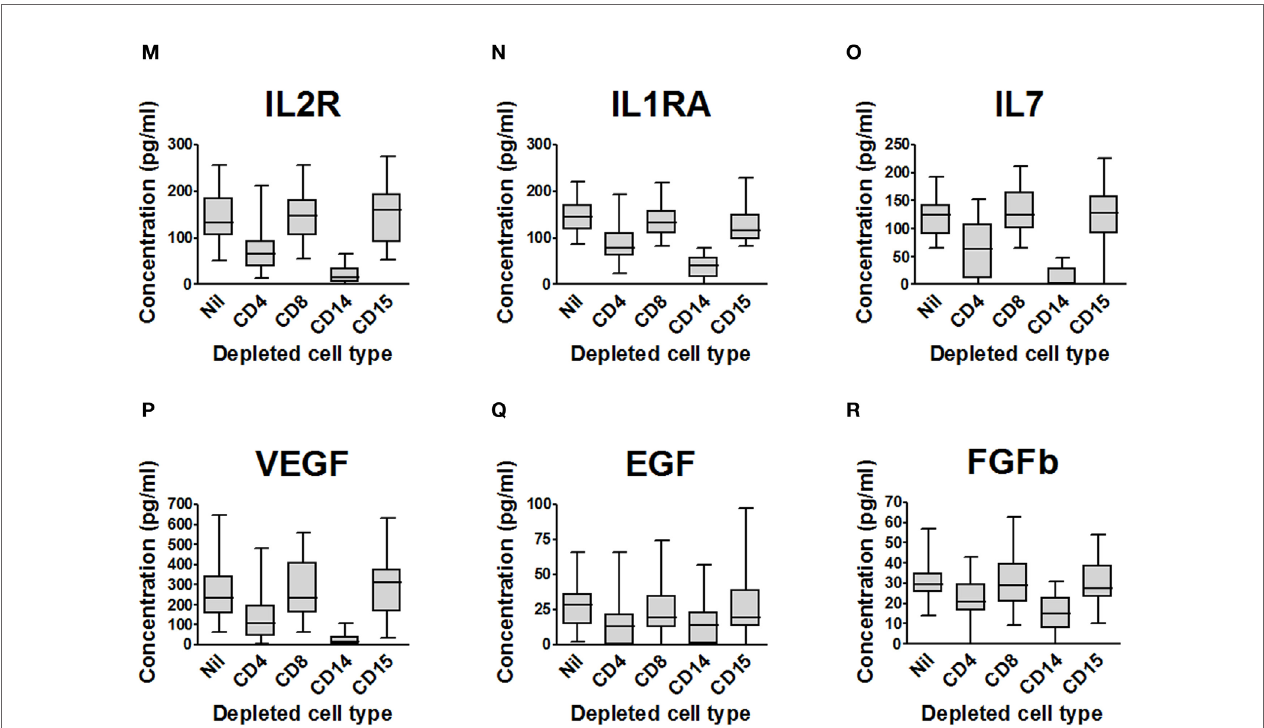
FigUre 2 | Impact of cell depletions on supernatant cytokines and chemokines from Mycobacterium tuberculosis -infected blood. (a–r) . Supernatants from the experiments presented in Figure 1 (blood from 20 donors depleted of CD4 + , CD8 + , CD14 + , CD15 + or no cells and infected with M. tuberculosis -lux for 96 h) were aspirated and stored at − 80°C until analysis by Luminex ™ technology. Box and whisker plots represent median, interquartile range, minimum and maximum values for each analyte. Abbreviations: VEGF, vascular endothelial growth factor; TNF, tumor necrosis factor; IFN, interferon; IL, interleukin; IL-2R, interleukin-2 receptor; IL-1RA, interleukin-1 receptor antagonist; FGFb, fibroblast growth factor basic; EGF, epidermal growth factor; CXCL, C-X-C motif ligand; CCL, C-C chemokine ligand; CD, cluster of